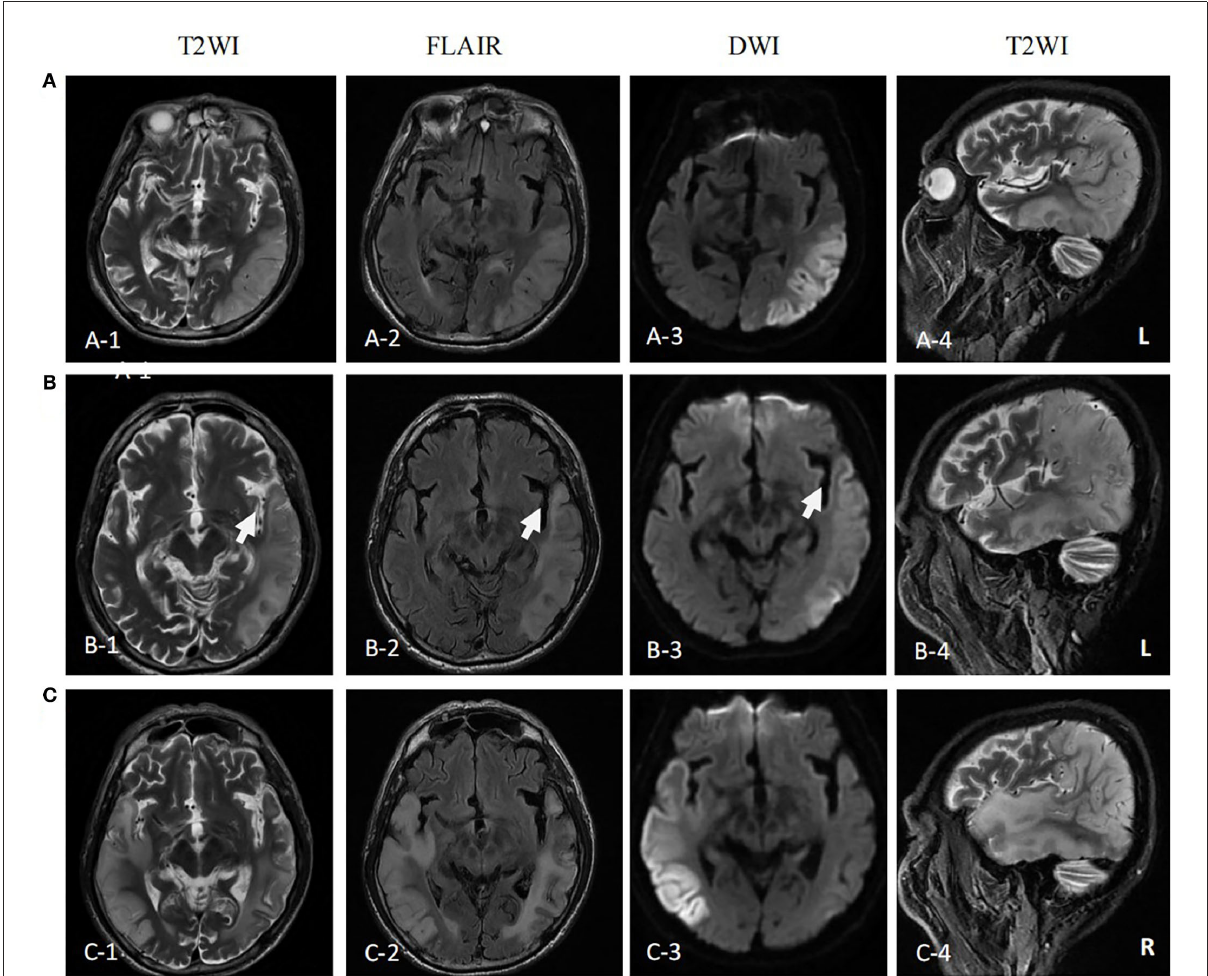
FIGURE1 MR images of the patient. (A) MR images performed on the first attack (12 days after onset) showed high signal intensity in occipital-temporal-parietal lobe hyperextension on T2-weighted, fluid attenuation inversion recovery (FLAIR), and diffusion-weighted imaging (DWI). (B) MR images performed on the remission (27 days after the first onset) showed a high signal intensity of DWI, FLAIR, and T2WI of the left occipital-temporal-parietal lobe was reduced. The focus of the temporal lobe is enlarged (arrow). (C) MR images performed on the recurrence (68 days from the first onset) showed new high signal intensity in the right occipital-temporal-parietal lobe hyperextension on T2-weighted, FLAIR, and